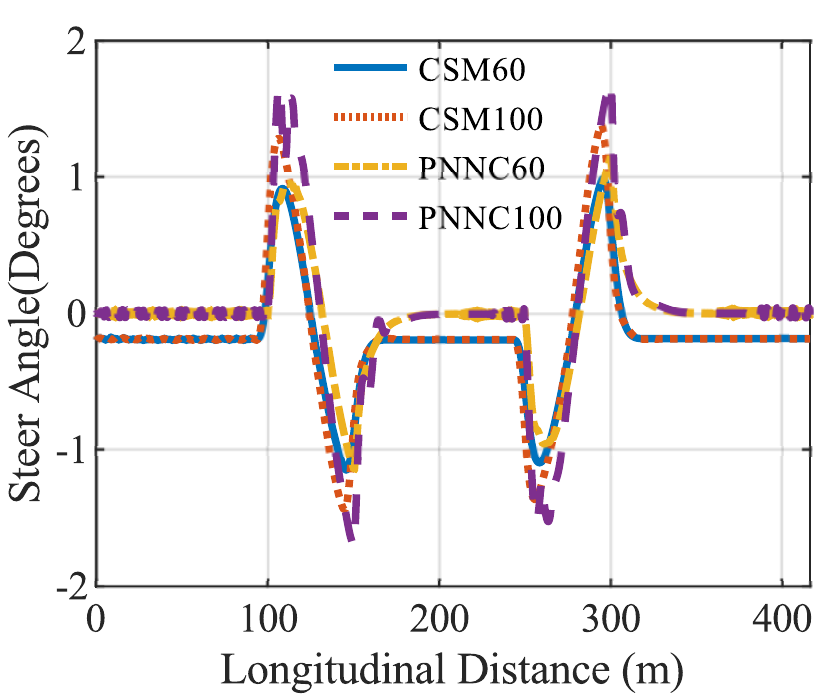
Figure 7. Road steer angle of the pure pursuit MPC controller and the proposed Neural Network controller (PNNC) for v x = 60 km/h and v x = 100